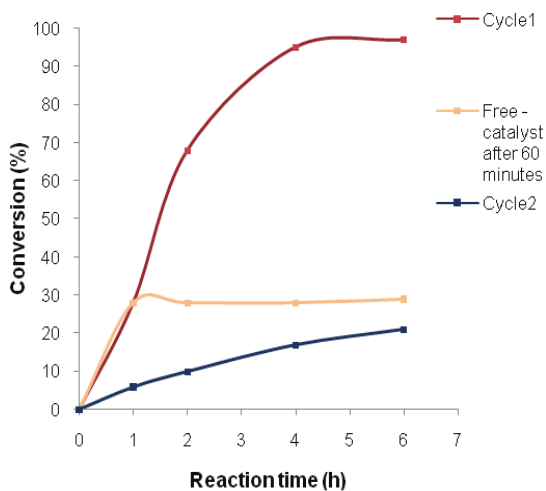
SiW O /TiO 4 12 40 2